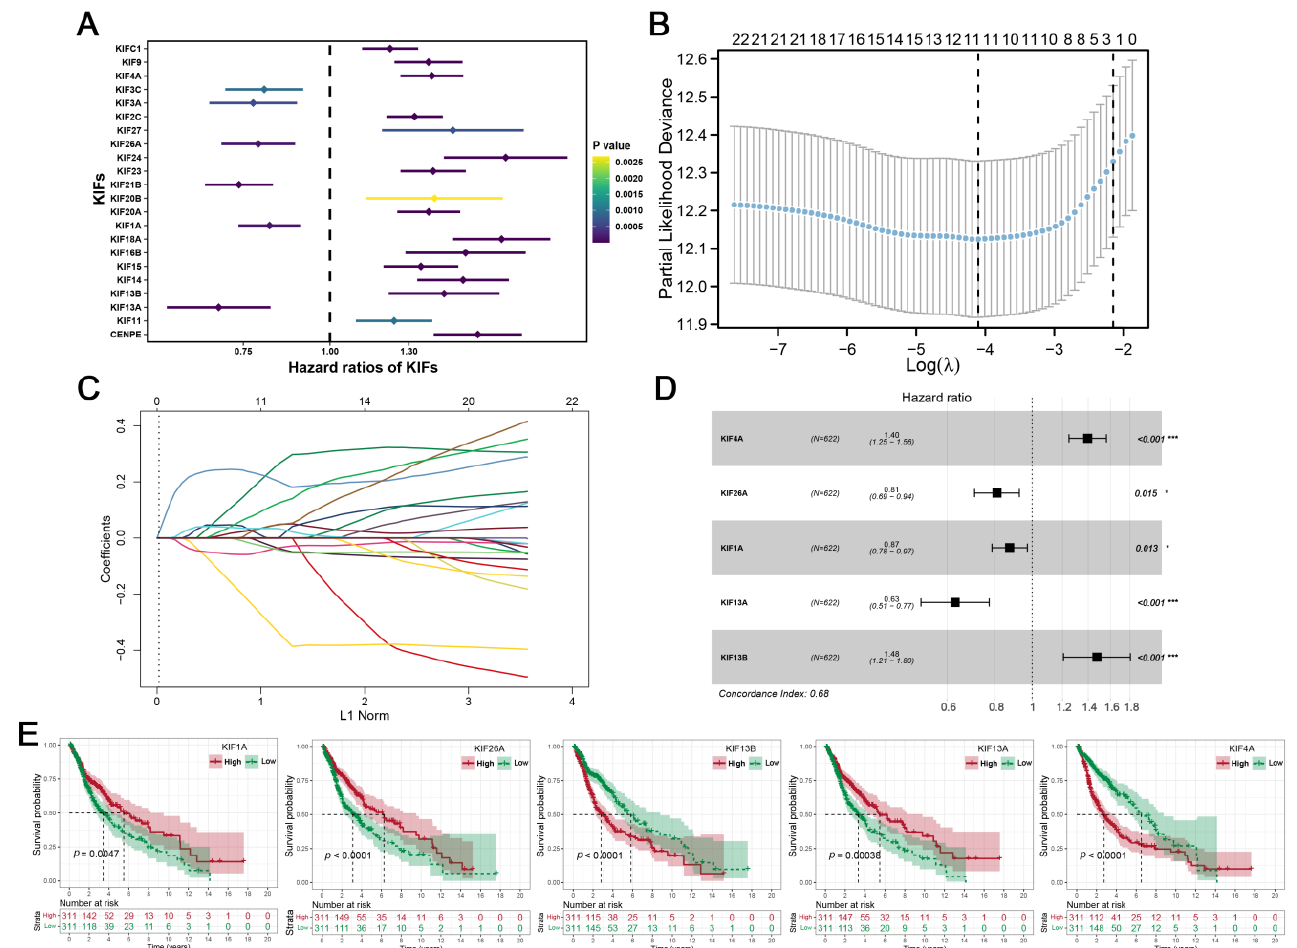
Figure 3. Identification of KIFs-based prognostic signature. Notes: ( A ) A total of 6 protective KIFs and 16 risk KIFs were identified by univariate Cox regression analysis; ( B – C ) LASSO regression analysis of the OS-related KIFs selected from univariate Cox regression analysis; ( D ) multivariate Cox regression analysis of prognostic KIFs identified by lasso regression analysis; ( E ) Kaplan–Meier survival curves analysis of 5 prognostic KIFs identified by multivariate Cox regression analysis in glioma.